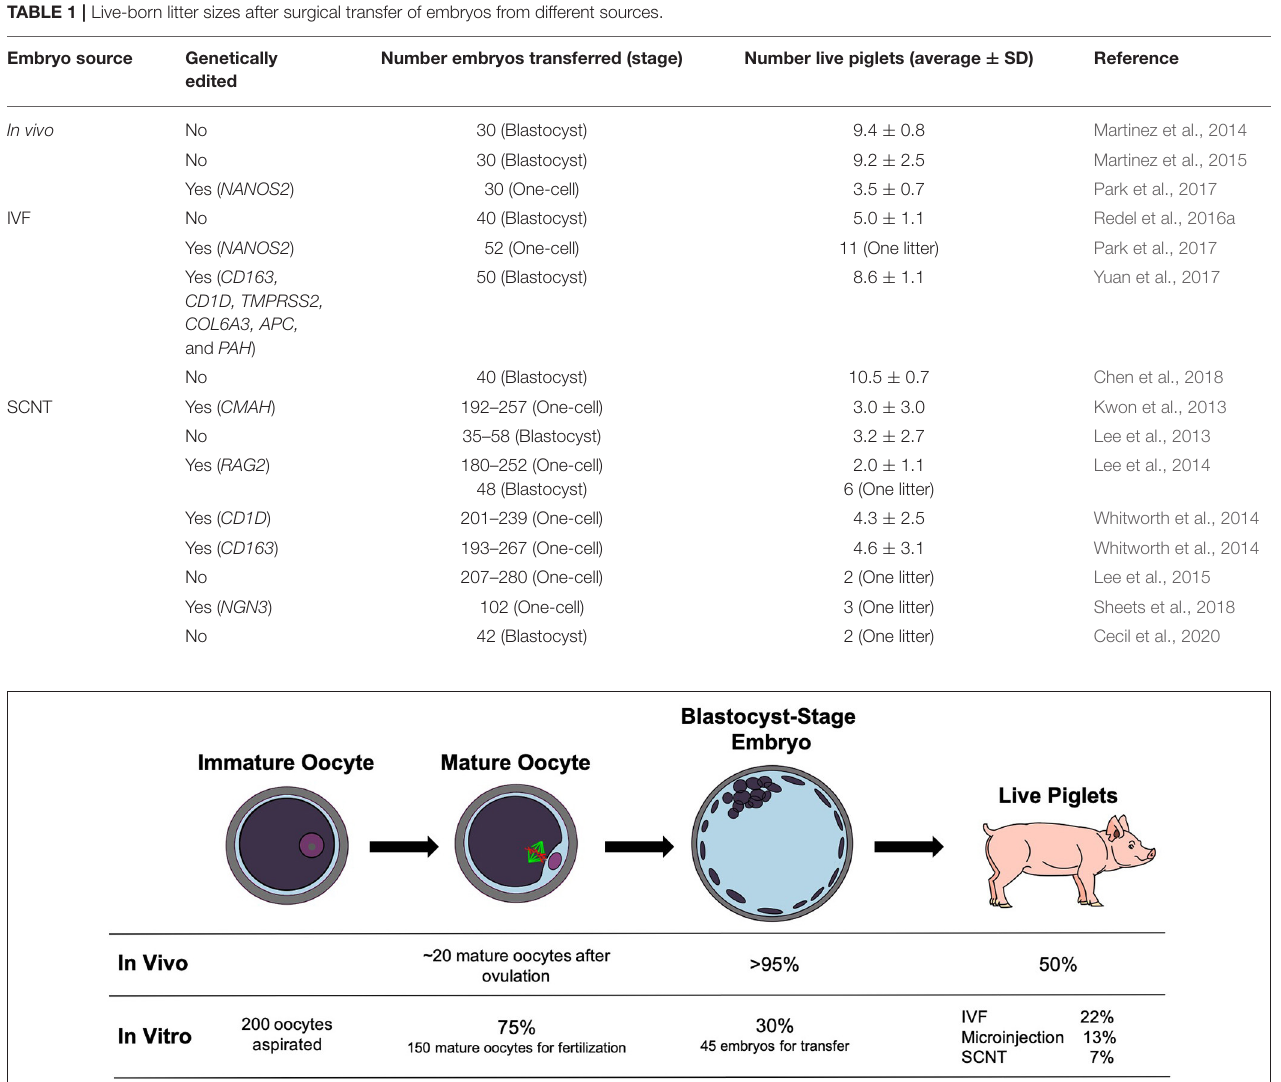
FIGURE 2 | Success rates of pregnancies from in vivo -derived embryos and in vitro -produced embryos by different manipulation procedures. Under in vivo conditions, ∼ 20 oocytes are ovulated each cycle with rates of fertilization and development to the blastocyst stage over 95%. About 50% of the embryos will produce live piglets. Under in vitro conditions, if 200 oocytes are aspirated from ovaries, ∼ 150 oocytes will mature to metaphase II (75%). After IVF or SCNT, roughly 30% will develop to the blastocyst stage for transfer into a surrogate gilt. Different manipulations, IVF with no manipulation, microinjection, and SCNT, result in decreased percentages of embryos that produce live piglets compared to in vivo